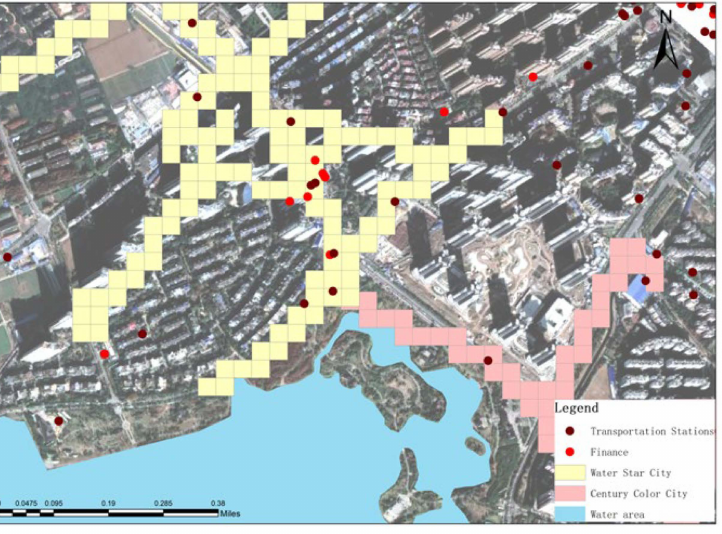
Figure 13. Types of the shared facilities